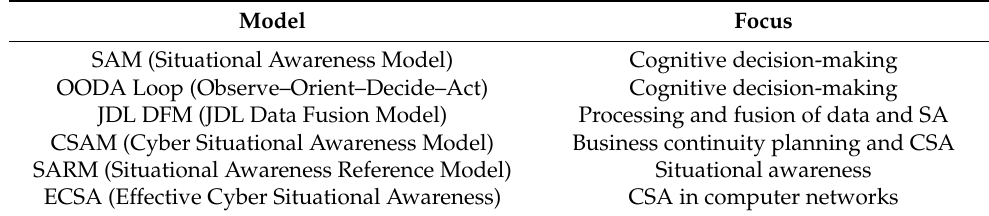
Table 2. Situational awareness models developed to provide quantitative indicators in decision-making.